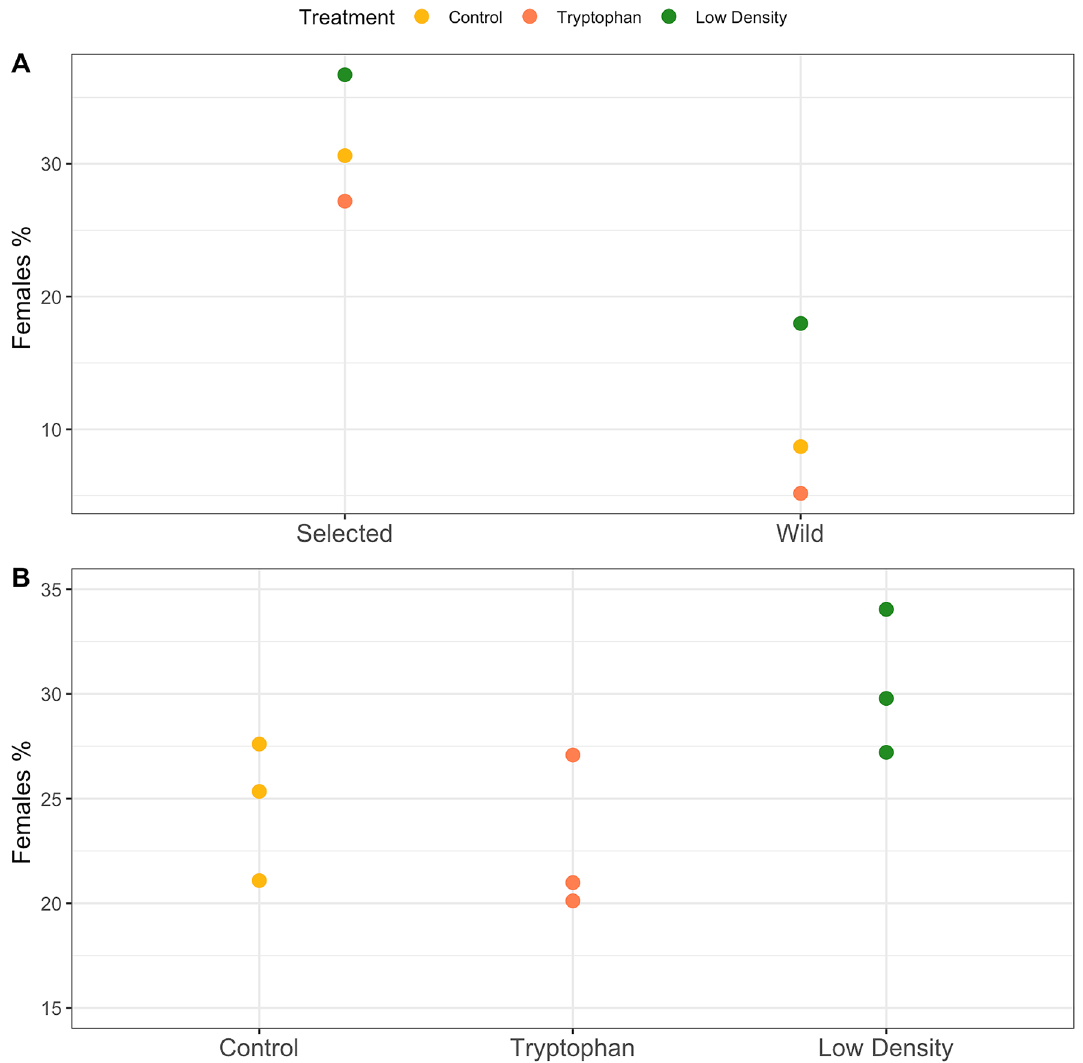
Figure 5. Sex-ratio at 328 dph of fish from the 3 treatments: Control, Low density and Tryptophan according to ( A ) genetic origin (wild vs selected) and ( B ) treatments with the tank replicates (n = 3)